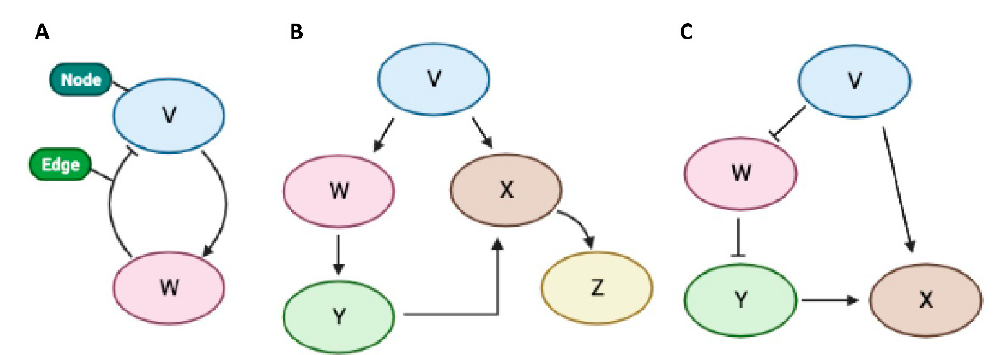
Figure 2. Schemes of a representative gene regulatory network. ( A ) Examples of nodes (coding genes, non-coding genes, non-coding RNAs, mRNAs, or proteins). Arrows indicate activation, whereas T-ending lines indicate repression, creating a feedback loop. ( B ) Representation of a positive feedforward loop. ( C ) Representative feedforward loop including repressive regulation between V, W, and Y.